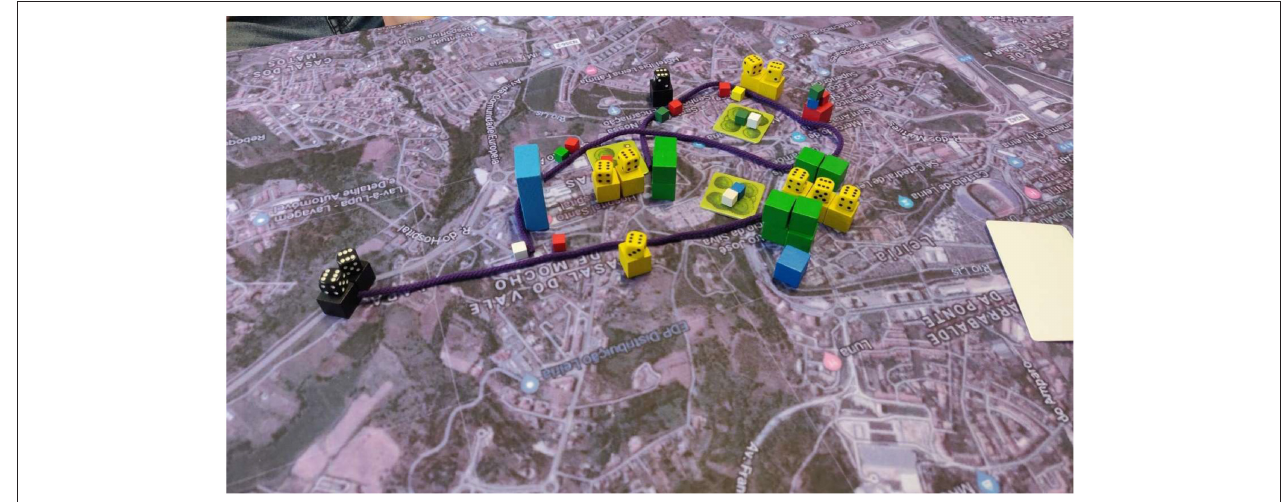
FIGURE 4 | Final visual result from the second game (south view).